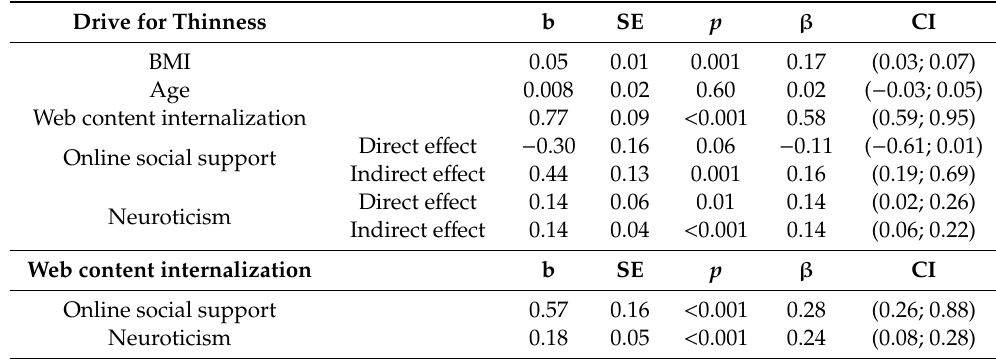
Table 2. Structural Equation Modeling (SEM) predicting the drive for thinness and web content internalization.